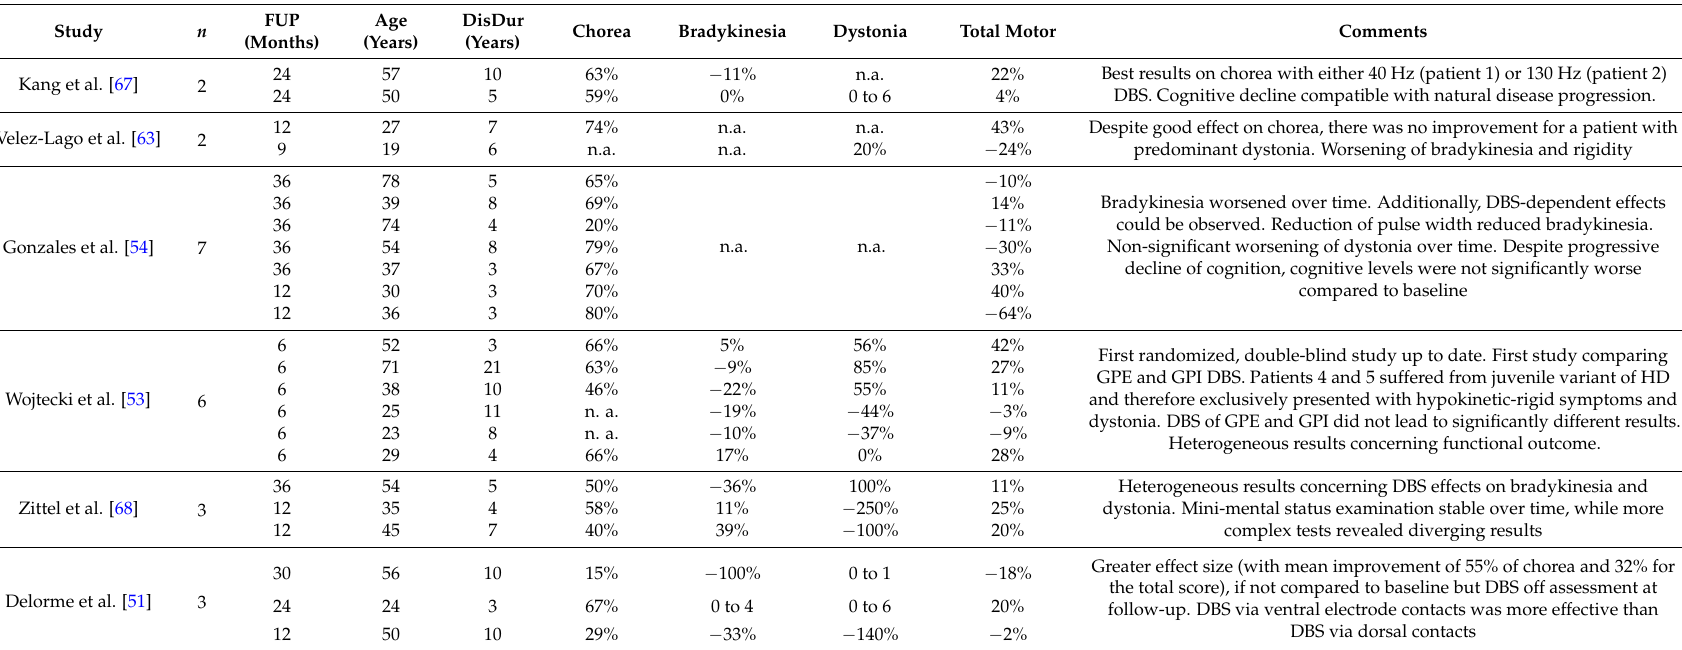
Table 2. Case series and trials ( n = number of patients) of pallidal DBS in